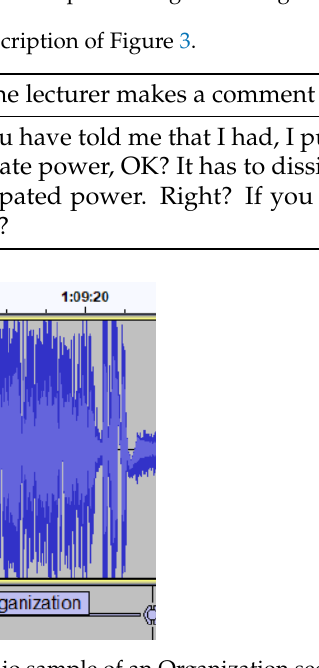
Figure 4. Audio sample of an Organization segment. Table 3. Transcription of Figure